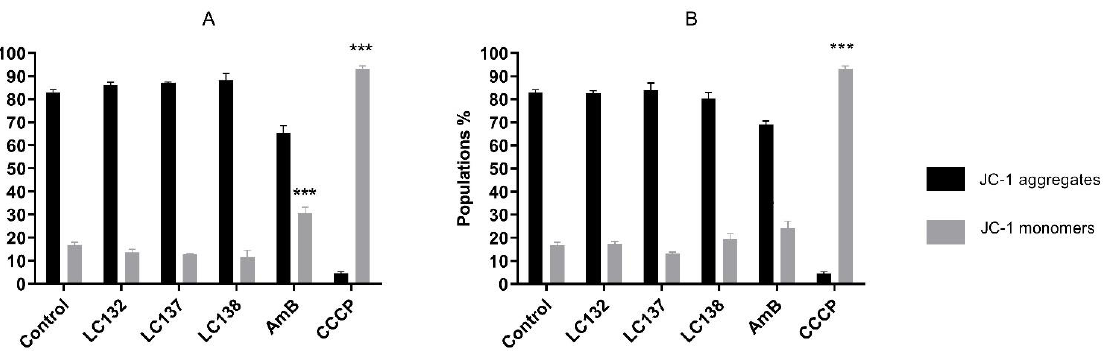
Figure 2. Mitochondrial membrane potential of L. infantum promastigotes incubated for 24 h with ( A ) IC 50 (13.0 µ M LC132, 137.0 µ M LC137, 125.4 µ M LC138 and 0.2 µ M AmB) and ( B ) 2 × IC 50 (25.9 µ M LC132, 274.0 µ M LC137, 250.8 µ M LC138 and 0.3 µ M AmB). Results are presented as percentage of cells with red fluorescence at ~590 nm (JC-1 aggregates—black bars—indicating dye accumulation in mitochondria) and green fluorescence at ~519 nm (JC-1 monomers—grey bars— indicating membrane depolarisation). Positive control for membrane depolarization corresponds to parasites treated with 50 μM carbonyl cyanide 3 -chlorophenylhydrazone (CCCP). Data are represented by mean ± SEM of three independent experiments, with triplicates. Asterisks represent statistically significant differences of treated related to non-treated parasites * p < 0.05; *** p < 0.0001.